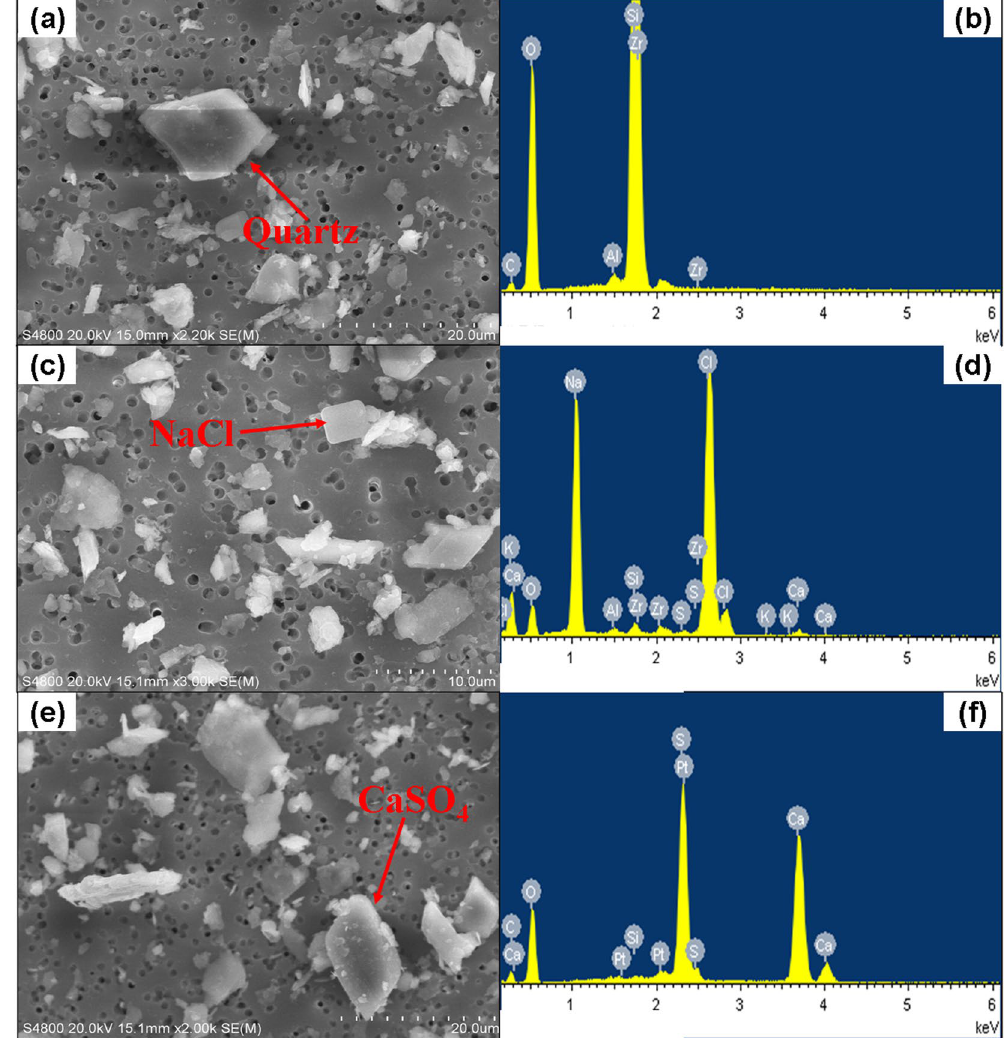
Figure 4. Transmission electron microscopy (TEM) images and energy-dispersive X-ray microanalyzer (EDX) spectra of typical individual components in the Taklimakan dust particles collected in Tazhong (39°N,